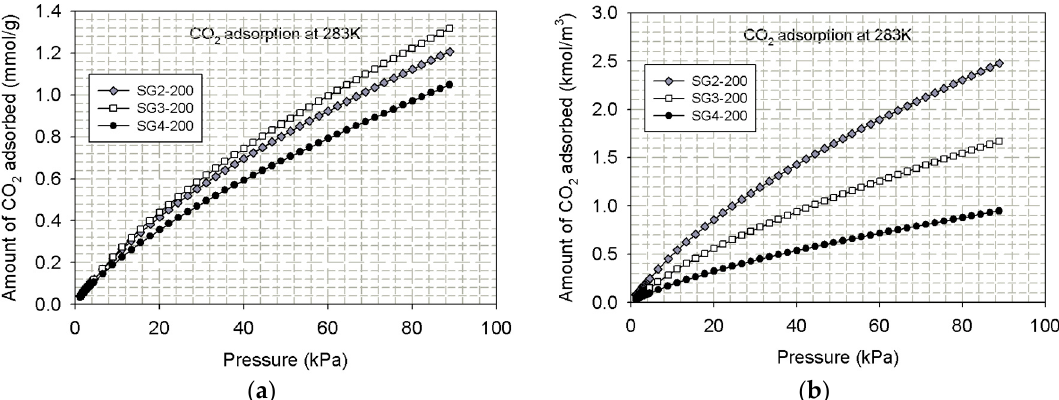
Figure 7. CO 2 adsorption isotherms at 283 K for porous silica glass prepared at different pH values. ( a ) adsorbed amount plotted in mmol/g and ( b ) adsorbed amount plotted in kmol/m 3.